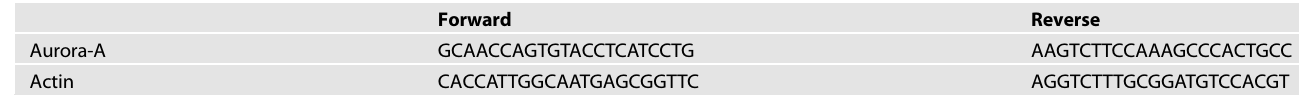
Table 3. The primers of RT-PCR assays.